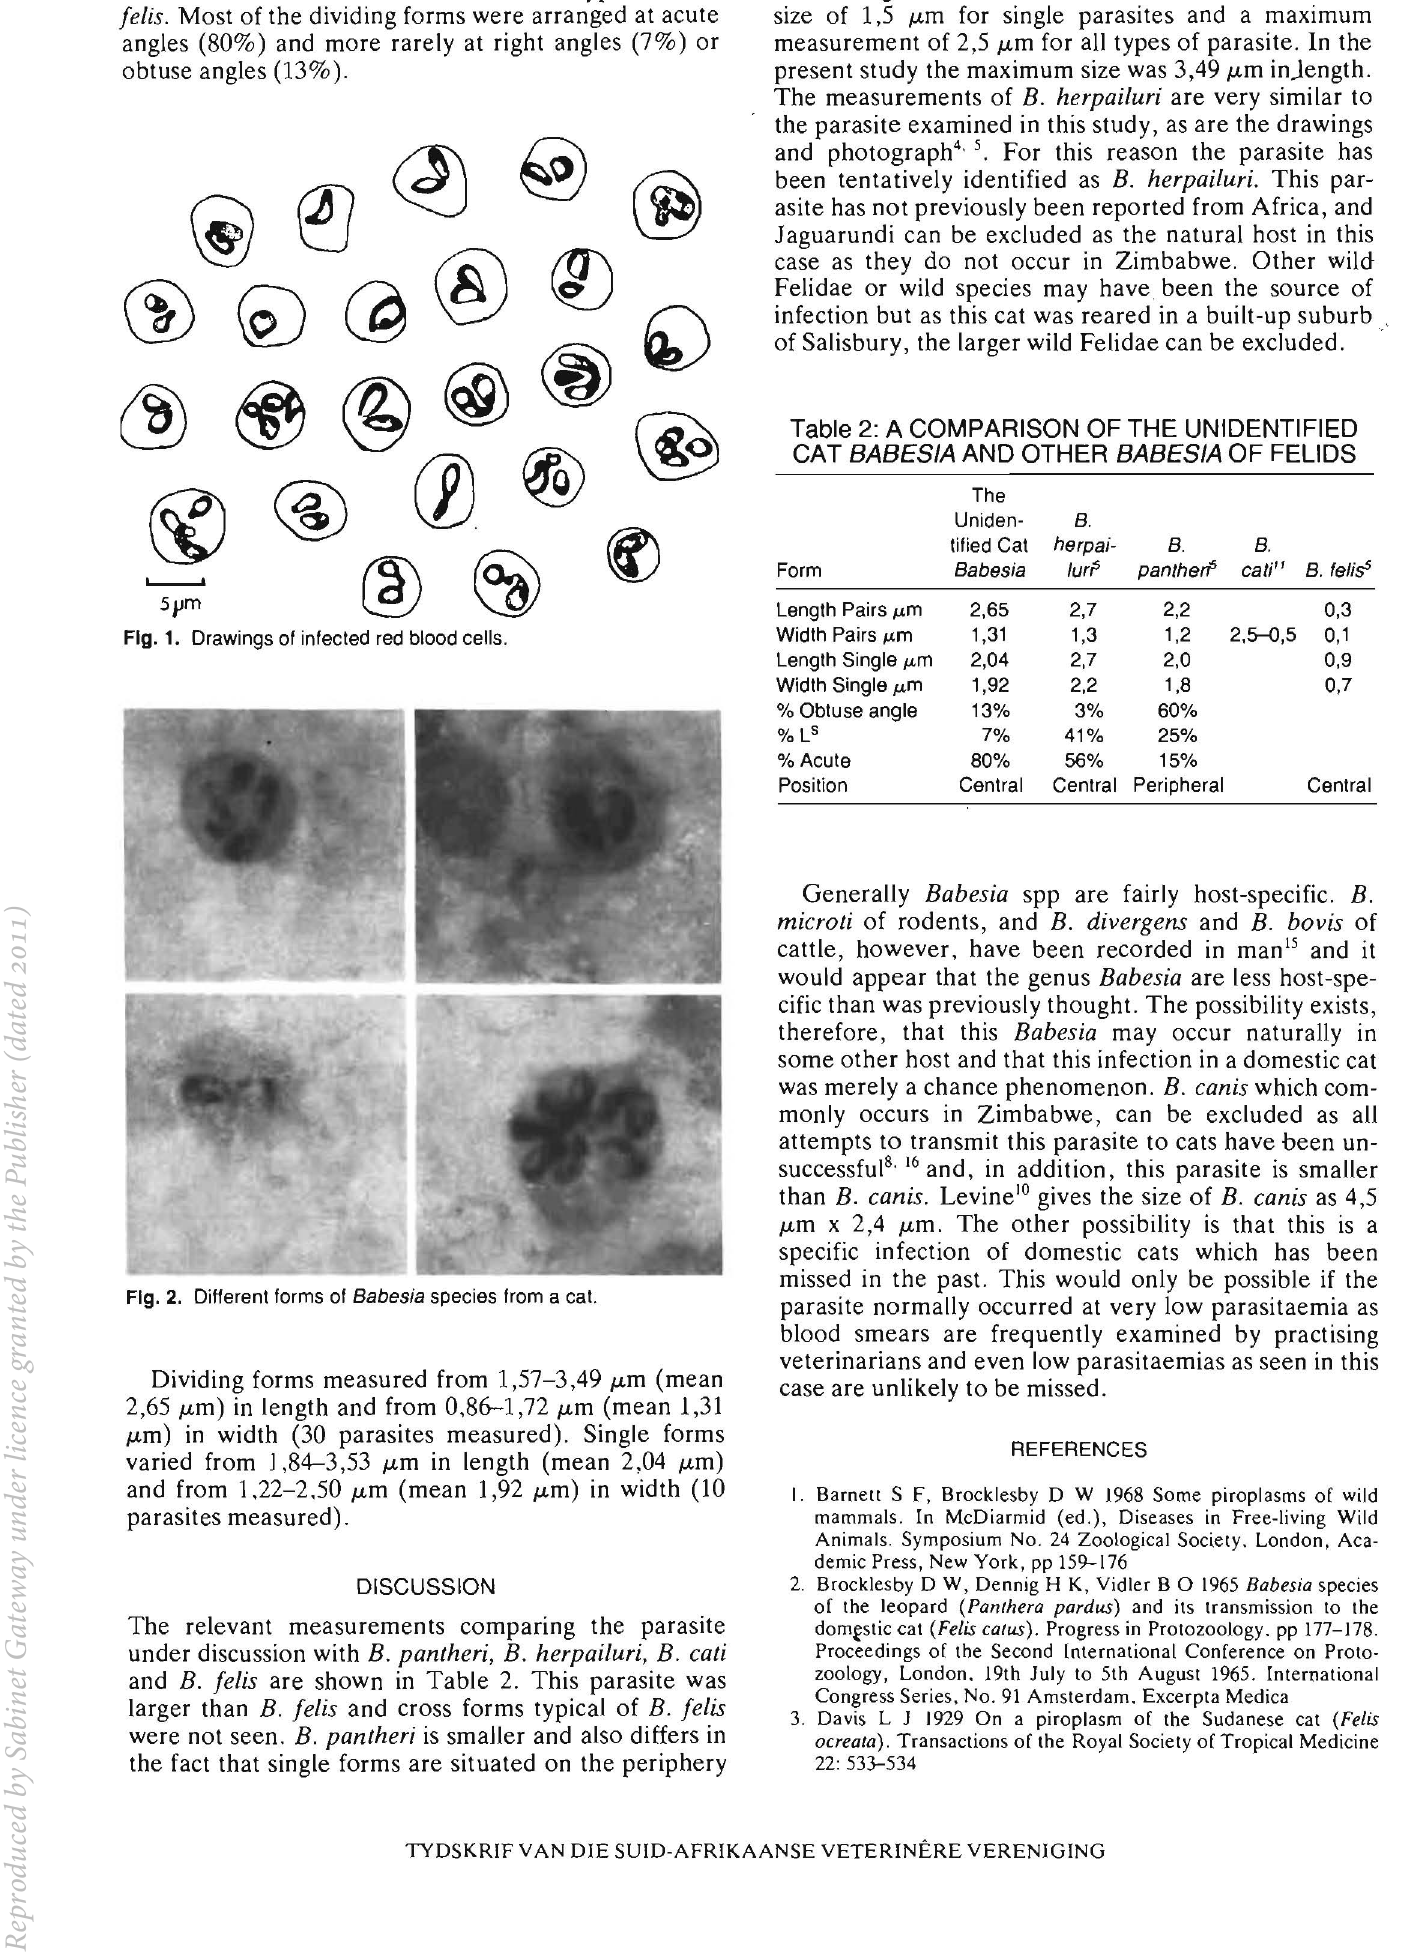
Dividing forms measured from 1,57-3,49 p,m (mean 2,65 p,m) in length and from 0,86-1,72 p,m (mean 1,31 p,m) in width (30 parasites measured). Single forms varied from J ,84-3,53 p,m in length (mean 2,04 p,m) and from 1,22-2,50 p,m (mean 1,92 p,m) in width (10 parasites measured).